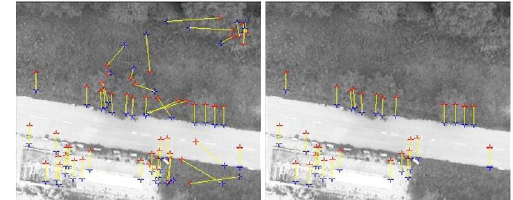
Figure 3: On the left is displayed the set of features tracked with the KLT algorithm. On the right the outlier feature set has been identified and removed using the RANSAC